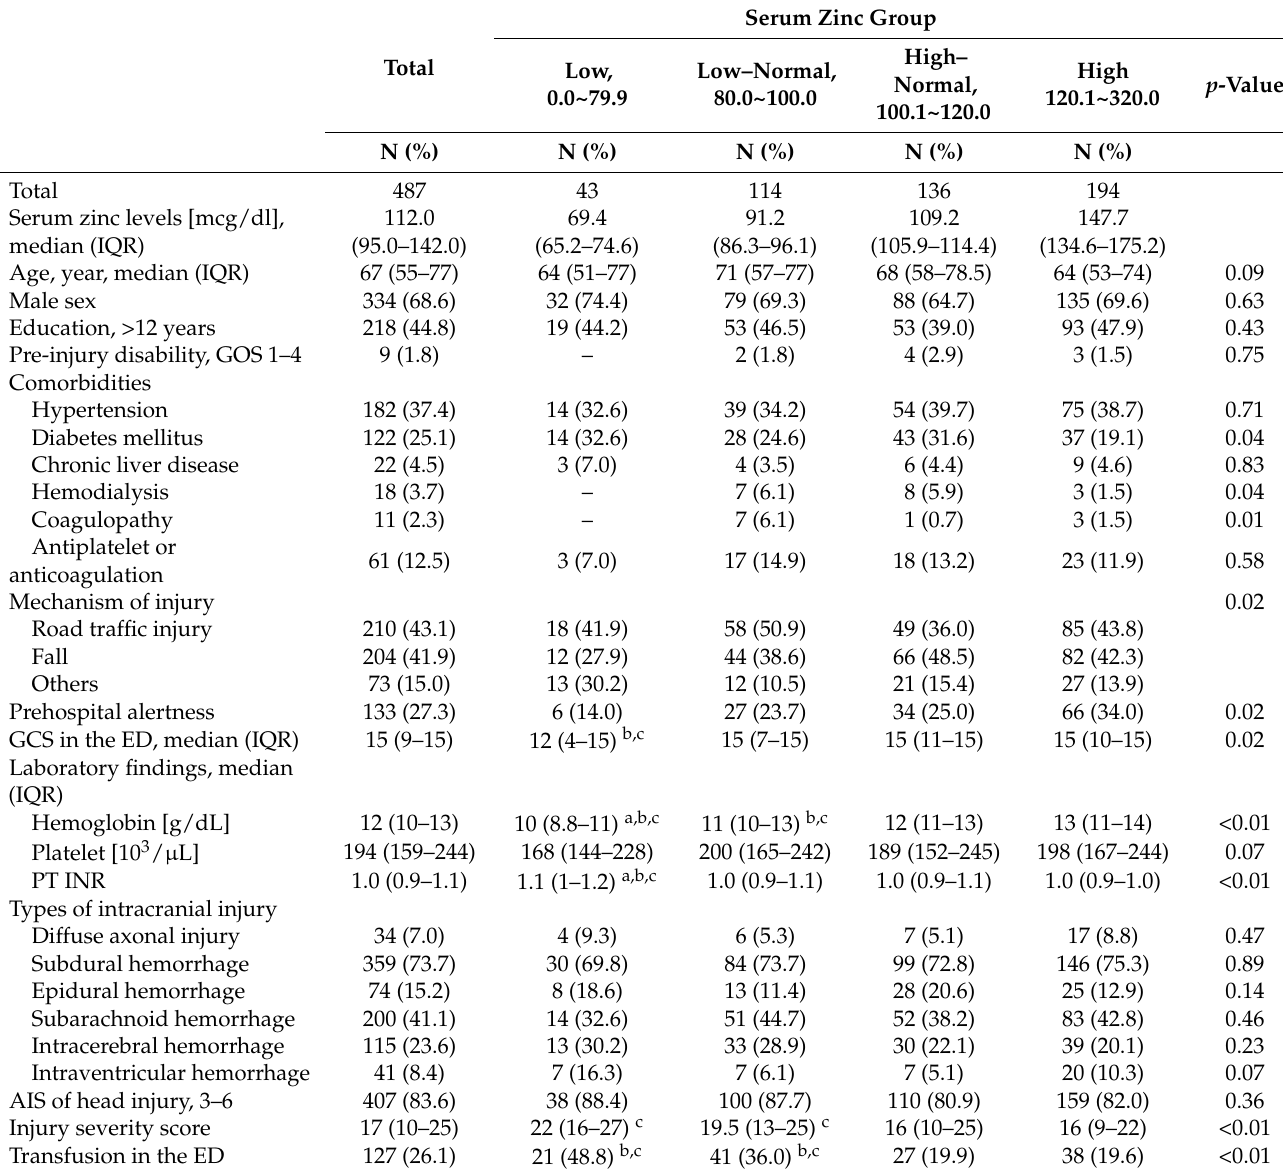
Table 1. Demographics of study population according to serum zinc